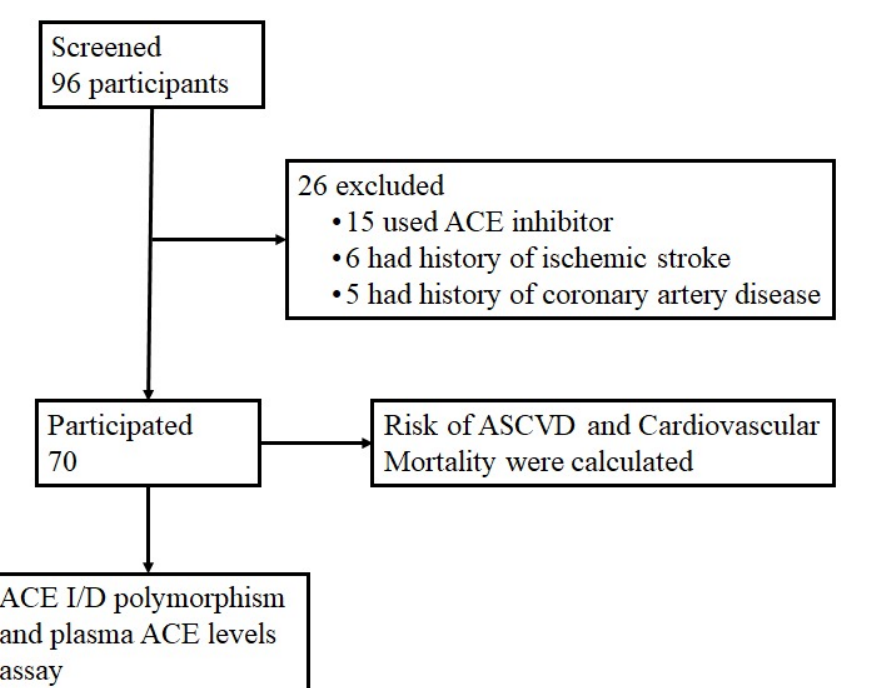
Figure 1. Flow chart for this cross-sectional study. There were 96 participants during the study period between May 2021 and December 2021. Twenty-six participants were not included for reasons including: under treatment with ACE inhibitor (15), had history of ischemic stroke (6), and had history of coronary artery disease (5). A total of 70 participants were included in this study. There were no statistically significant differences when comparing men and women included in this study. The risk of ASCVD and cardiovascular mortality were calculated with CKD patch. Blood plasma from the participants were used to identify ACE I/D polymorphism and measure plasma ACE level.